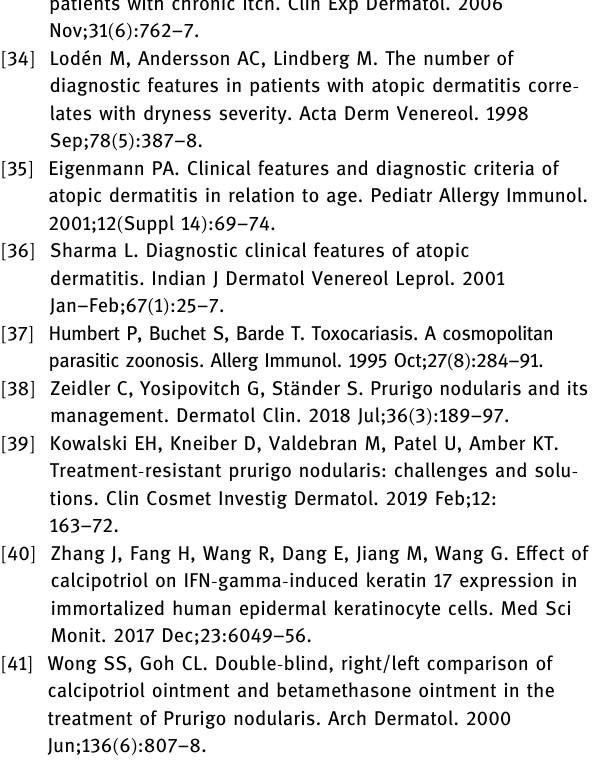
e ff ects of topical pimecrolimus in non - atopic prurigo nodularis: results of a randomized, hydrocortisone - controlled, double